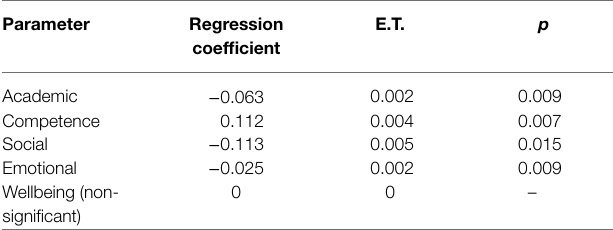
TABLE 2 | Results (regression coefficients and significant effects) for the first independent variable: time spent in Internet during a typical weekday (Time_